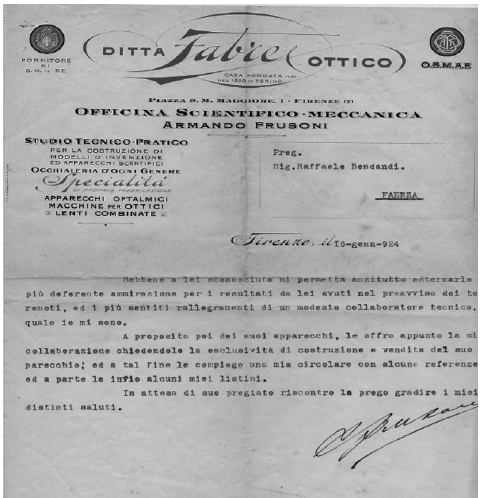
Fig. 6. Letter of Armando Frusoni, proprietor of the Officina Scientifico-Meccanica Frugoni , who offers Bendandi his collaboration, asking for the exclusivi- ty for the manufacture and sale of his device.